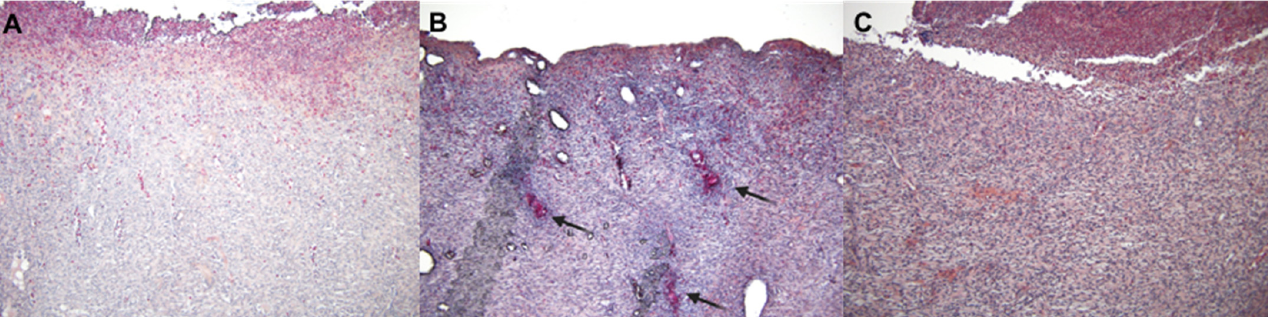
Figure 5. The histopathological score of the inflammatory response. The statistical analysis was performed with the parametric one-way ANOVA test with post hoc Dunn’s comparison test (* p < 0.05).